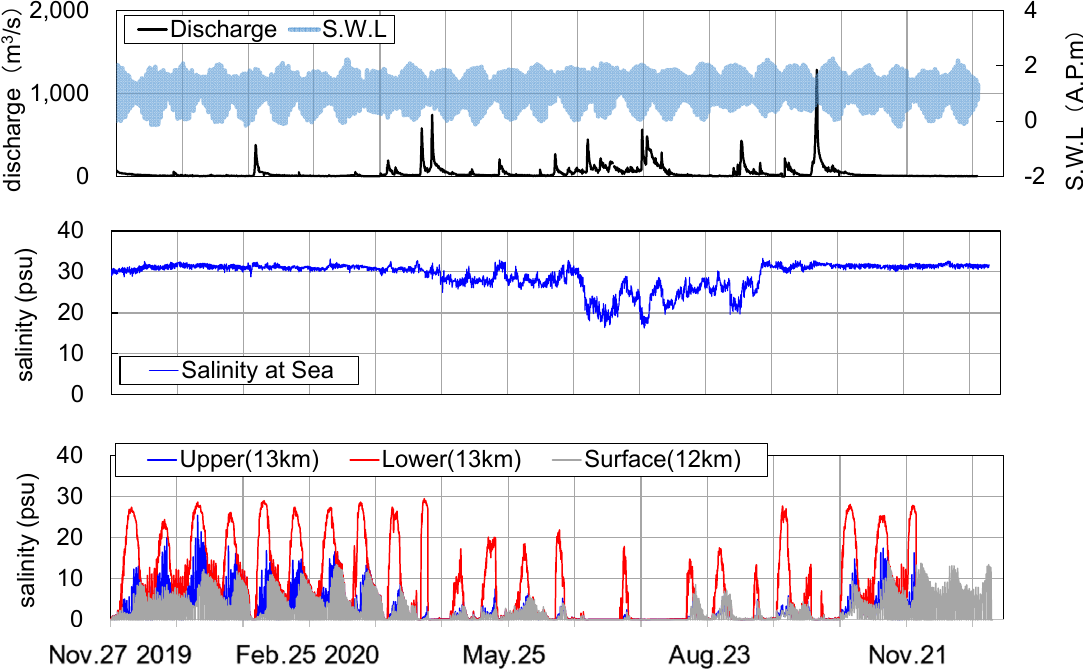
Figure 6. The Akigase Weir (35 km) discharge and tidal level recorded at the Harumi Observatory (Tokyo Bay).